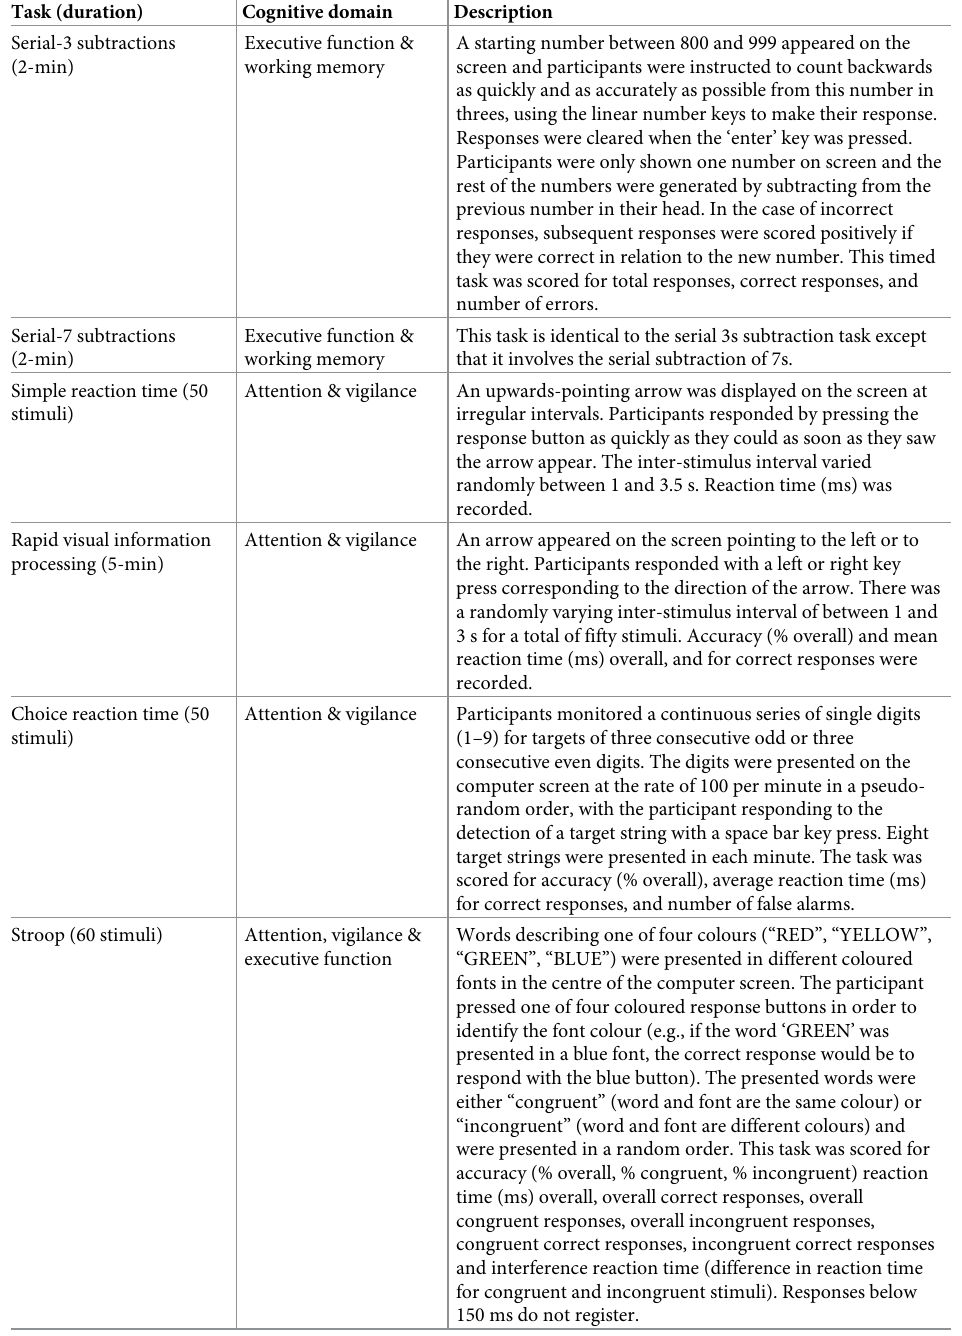
Table 3. Computerised Mental Performance Assessment System (COMPASS) task